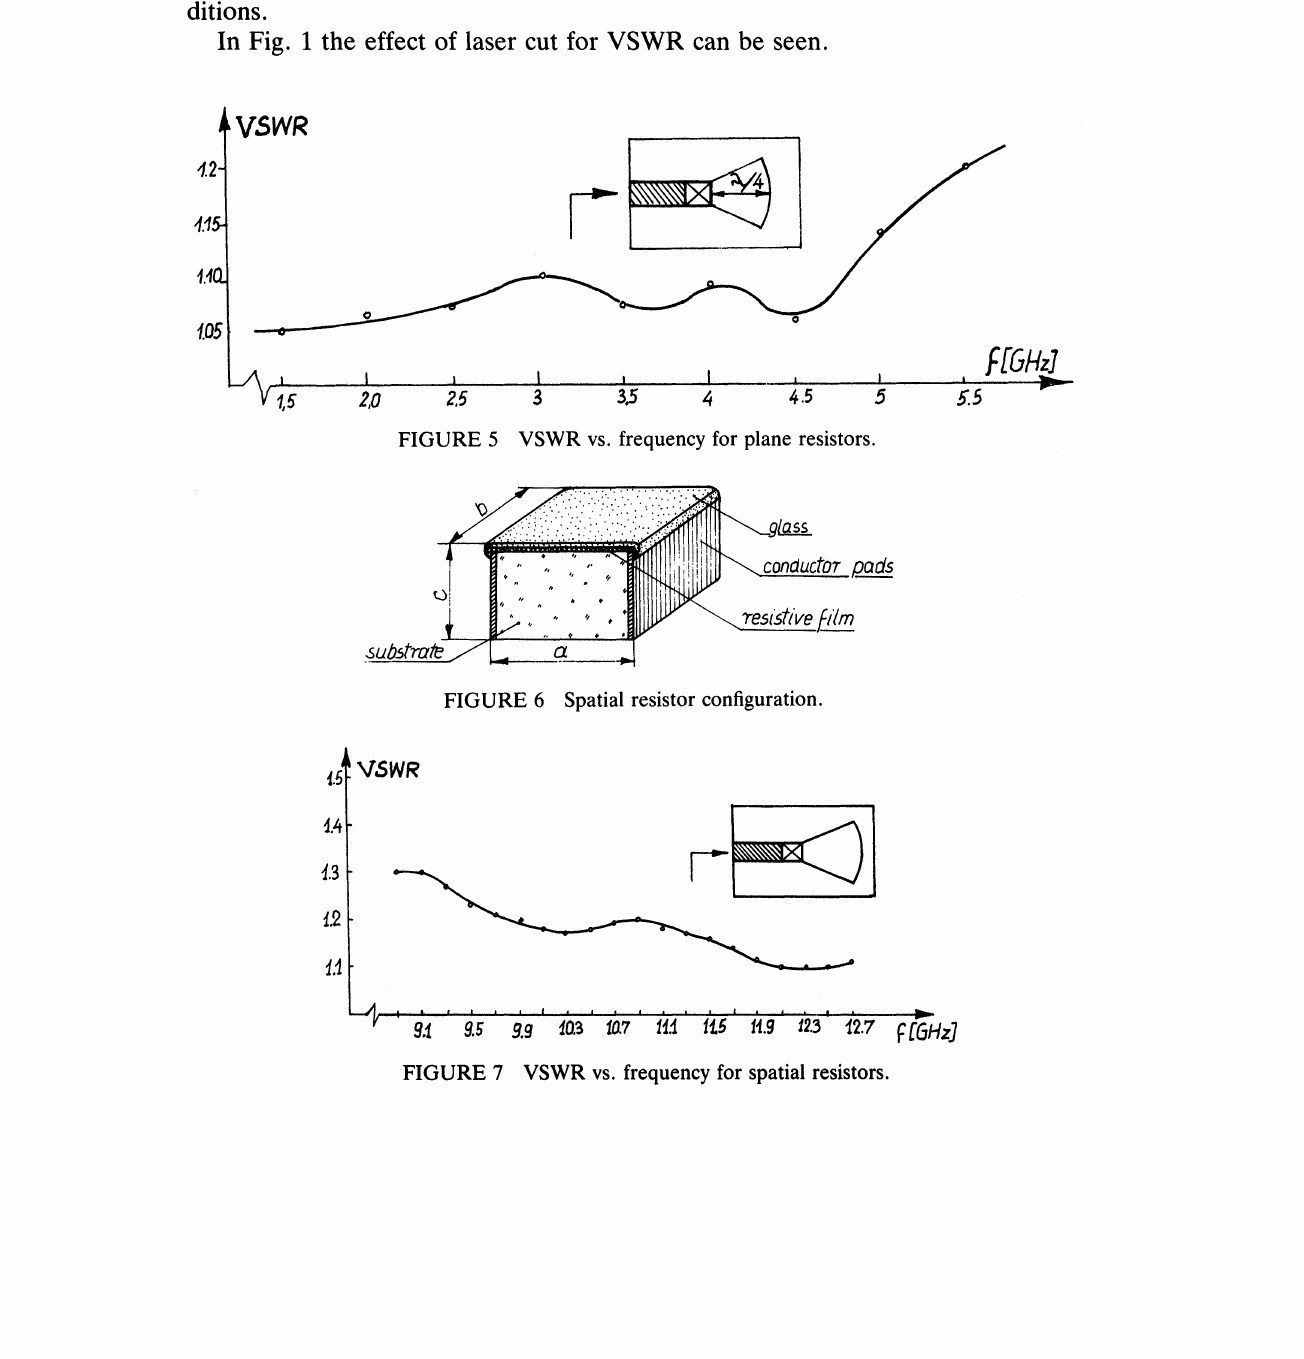
FIGURE 5 VSWR vs. frequency for plane resistors.